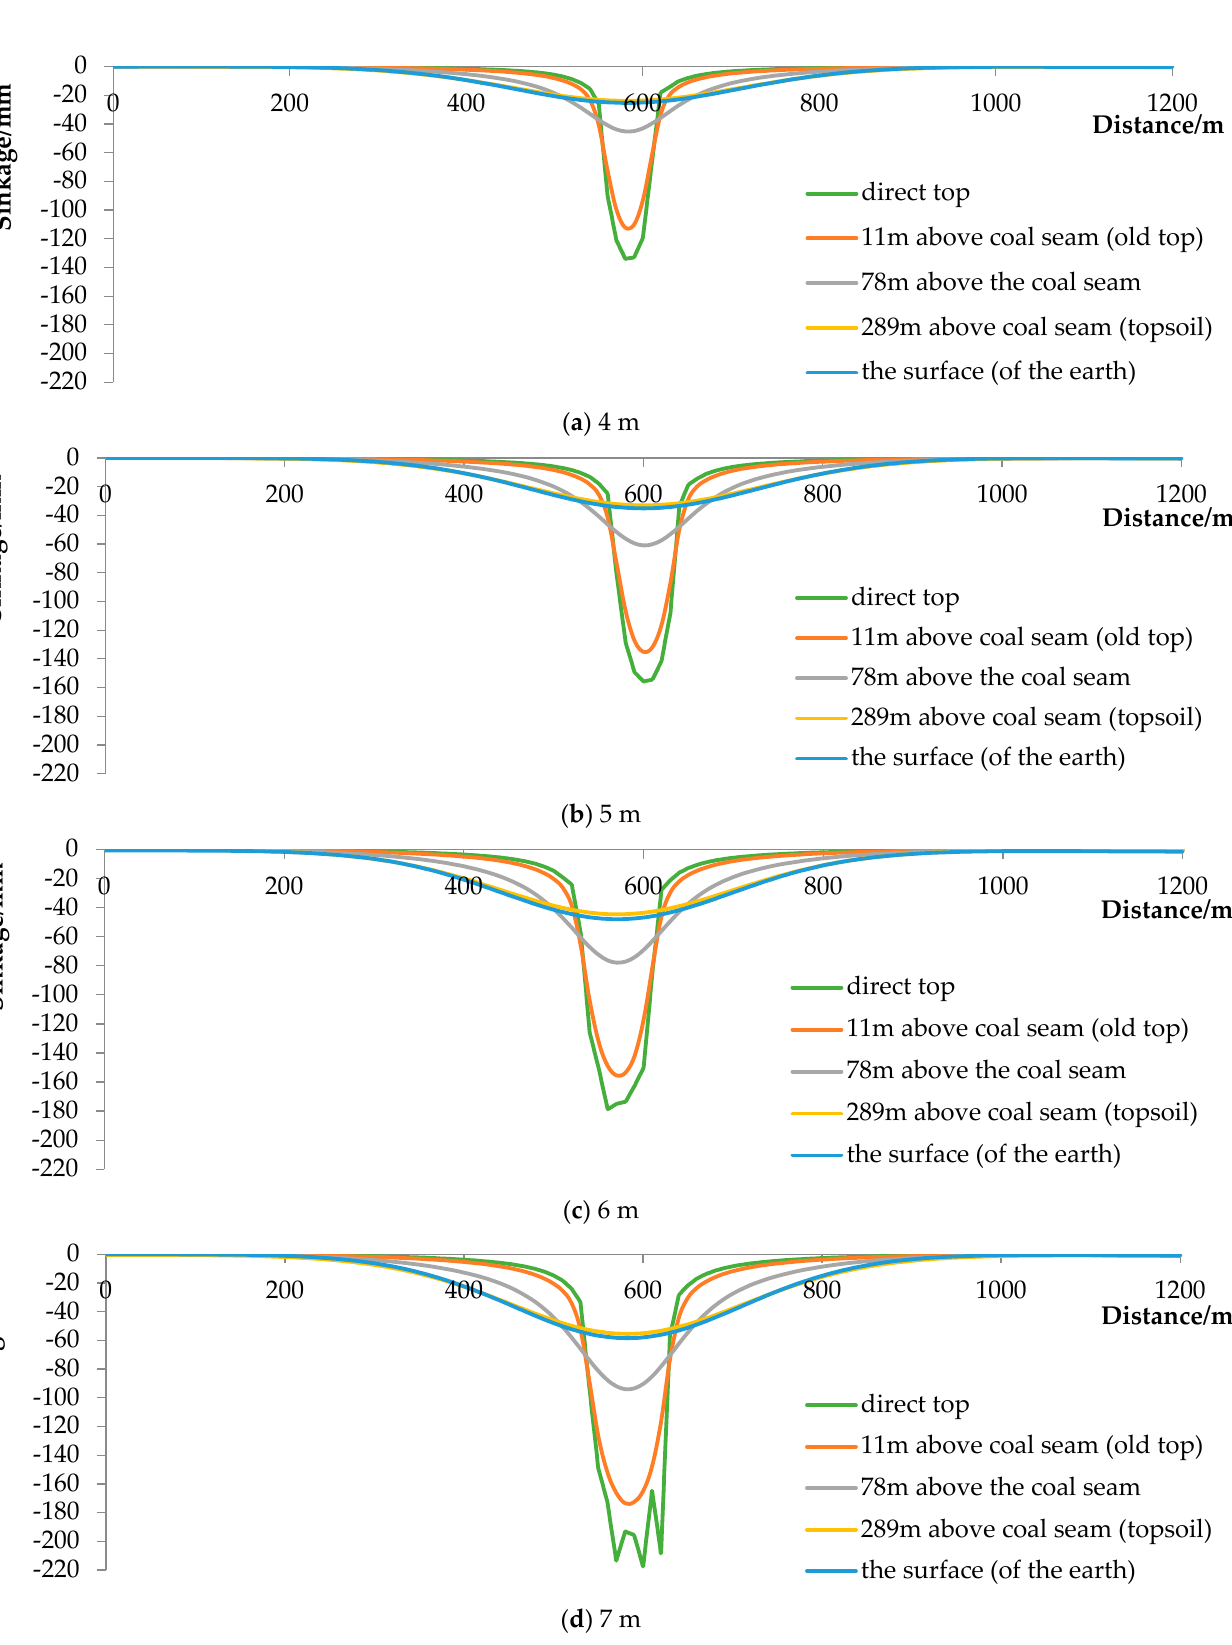
Figure 13. Vertical displacement cloud map of ( a ) 4 m, ( b ) 5 m, ( c ) 6 m, and ( d ) 7 m.